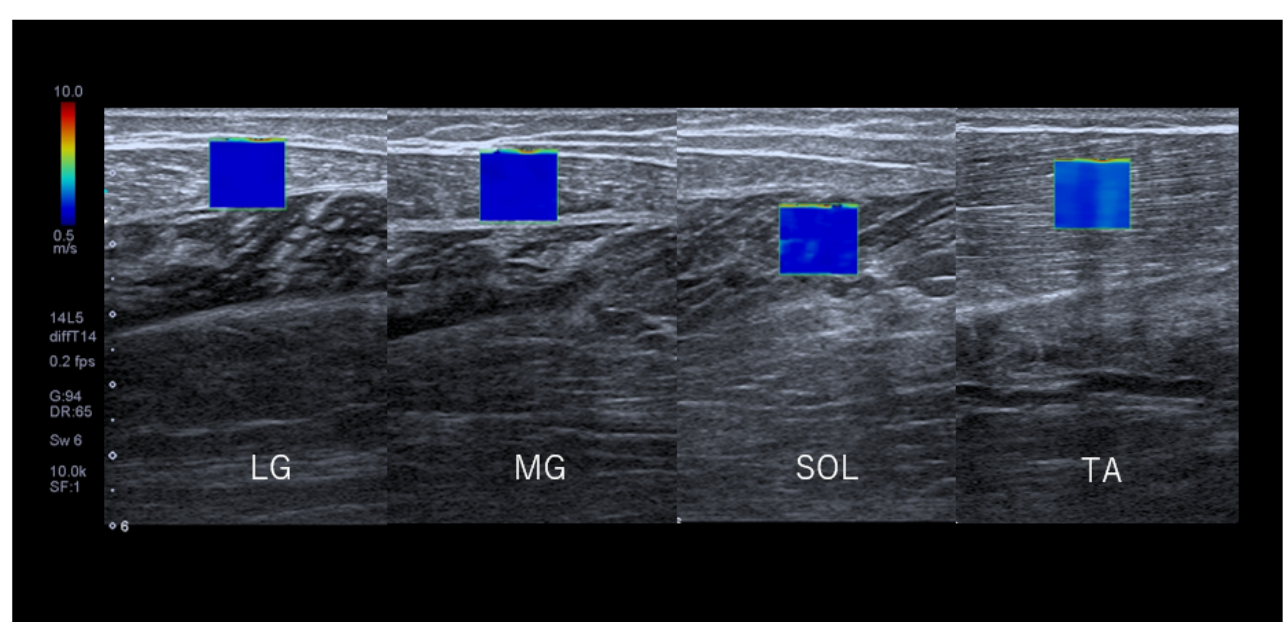
Figure 4. Image of shear wave elastography of lower leg muscles. LG: Lateral gastrocnemius, MG: Medial gastrocnemius; SOL: Soleus; TA: Tibialis anterior. ROI: Region of interest: 1 cm × 1 cm. Permission with Plos One 2021 [21].